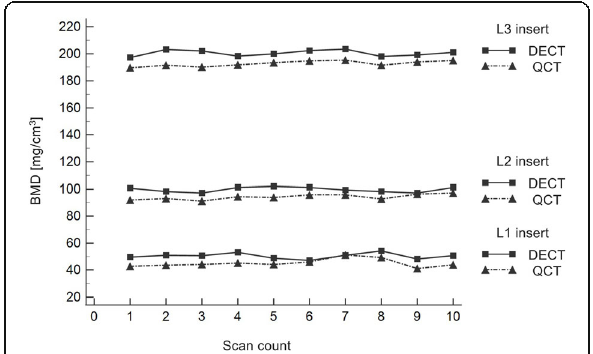
Fig. 4 Illustration of BMD values derived from DECT and QCT for the three HA-inserts L1 (50 mg/cm3), L2 (100 mg/cm3), and L3 (200 mg/ cm3). Comparisons of measured BMD values of L1, L2, and L3 with their true BMD values showed significantly lower values when using QCT (all p < 0.001), whereas DECT-derived BMD values differed not significantly compared to true BMD values (all p ≥ 0.509). BMD, Bone mineral density;